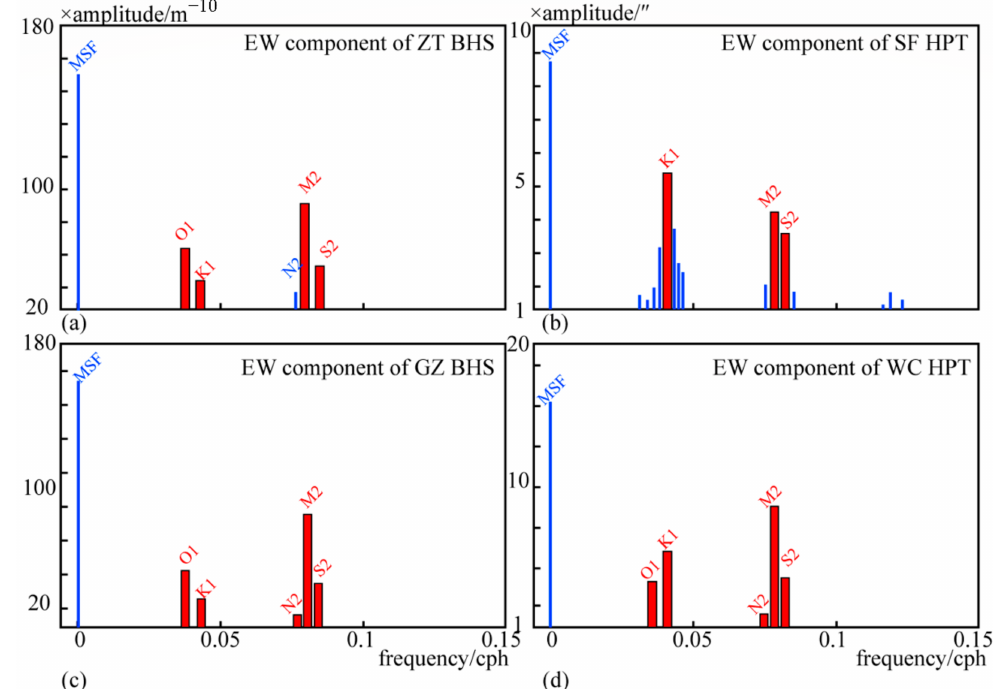
Figure 10. Harmonic analysis of the geodetic time series shown in Figure 9. All the descriptions are the same as the Figure 7. ( a ) is the EW component of the ZT BHS, ( b ) the EW component of the SF HPT, ( c ) the EW component of the GZ BHS, ( d ) the EW component of the WC